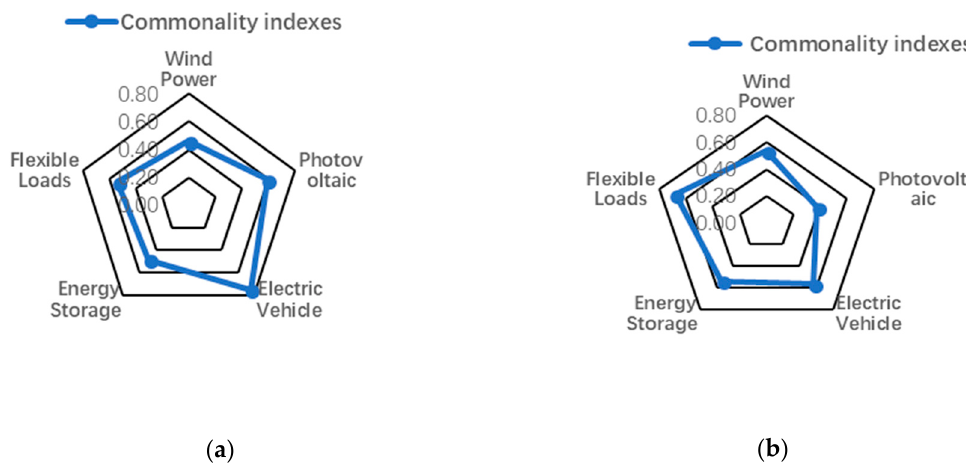
Figure 7. The comprehensive scores of commonality indexes of various DSER in a certain region. ( a ) The score of various DSER in region 1; ( b ) The scores of various DSER in region 2.